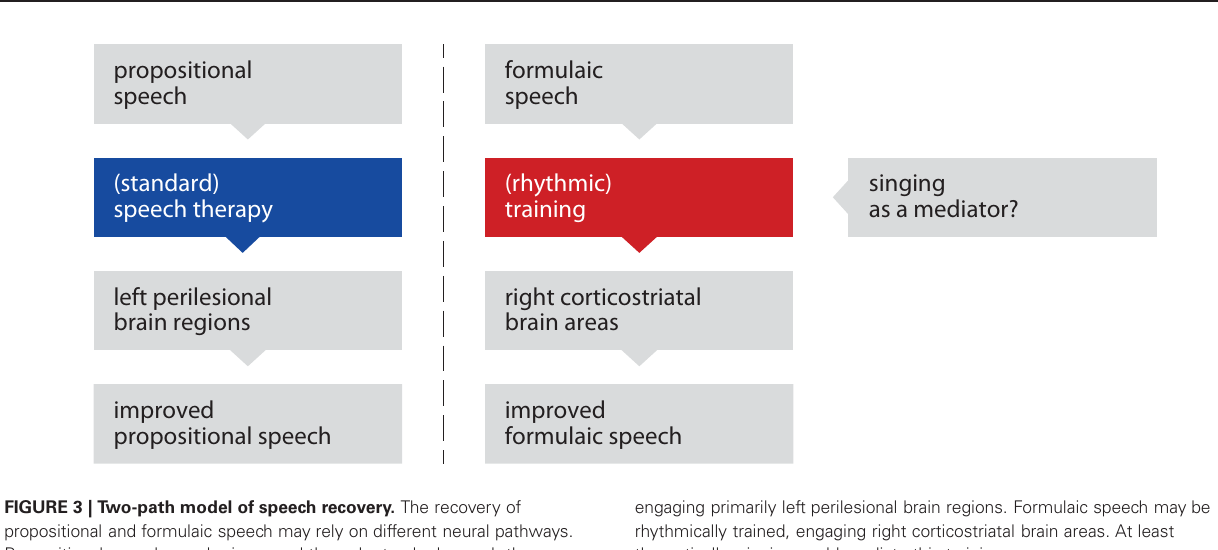
engaging primarily left perilesional brain regions. Formulaic speech may be rhythmically trained, engaging right corticostriatal brain areas. At least theoretically, singing could mediate this training